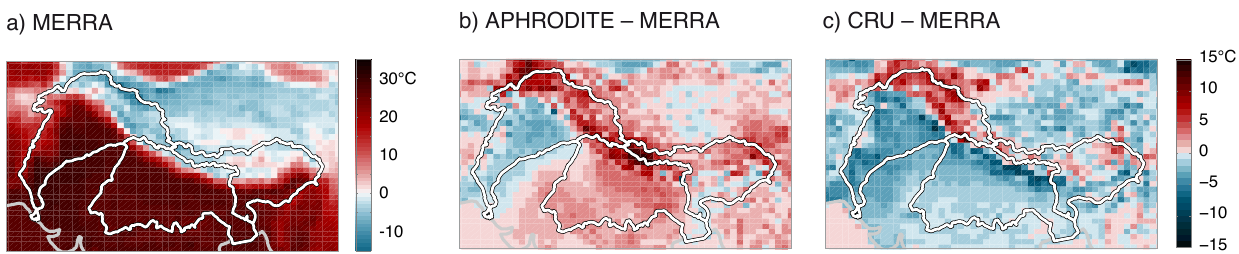
Figure 6. Difference between MERRA temperature and observation-based data. (a) Annual mean MERRA temperature. (b, c) Annual mean MERRA temperature bias corrected with observations: APHRODITE and CRU